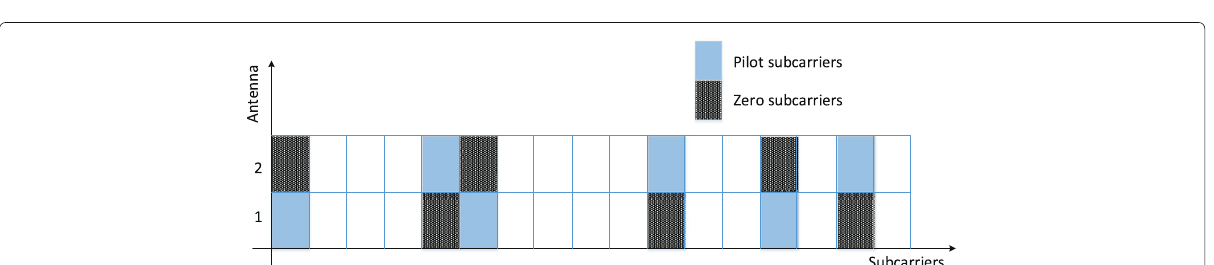
Fig. 2 Orthogonal pilot allocation representation using N = 16 subcarriers and N p = 3